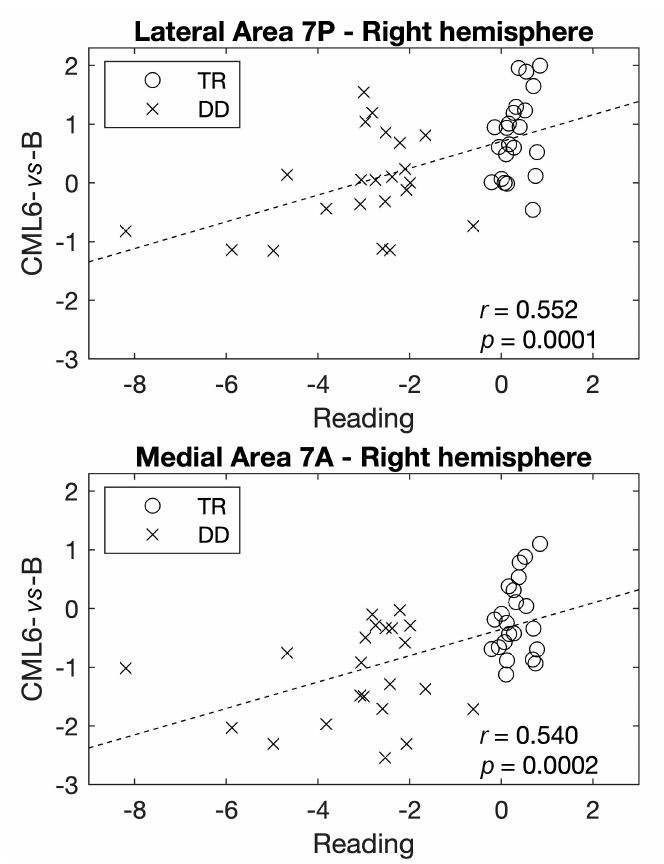
Figure 3. Bonferroni significant correlations between the mean activation of contrast maps within the significant ROIs and the neuropsychological domains in the total sample (n = 44). ( a ) Correlation between the mean activation of CML6- vs -B within the right lateral area 7P and reading. ( b ) Correlation between the mean activation of CML6- vs -B within the right medial area 7A and reading. Reading represents a mean score of text [98,99], single unrelated words and pronounceable pseudo-words [100,104] reading tests.